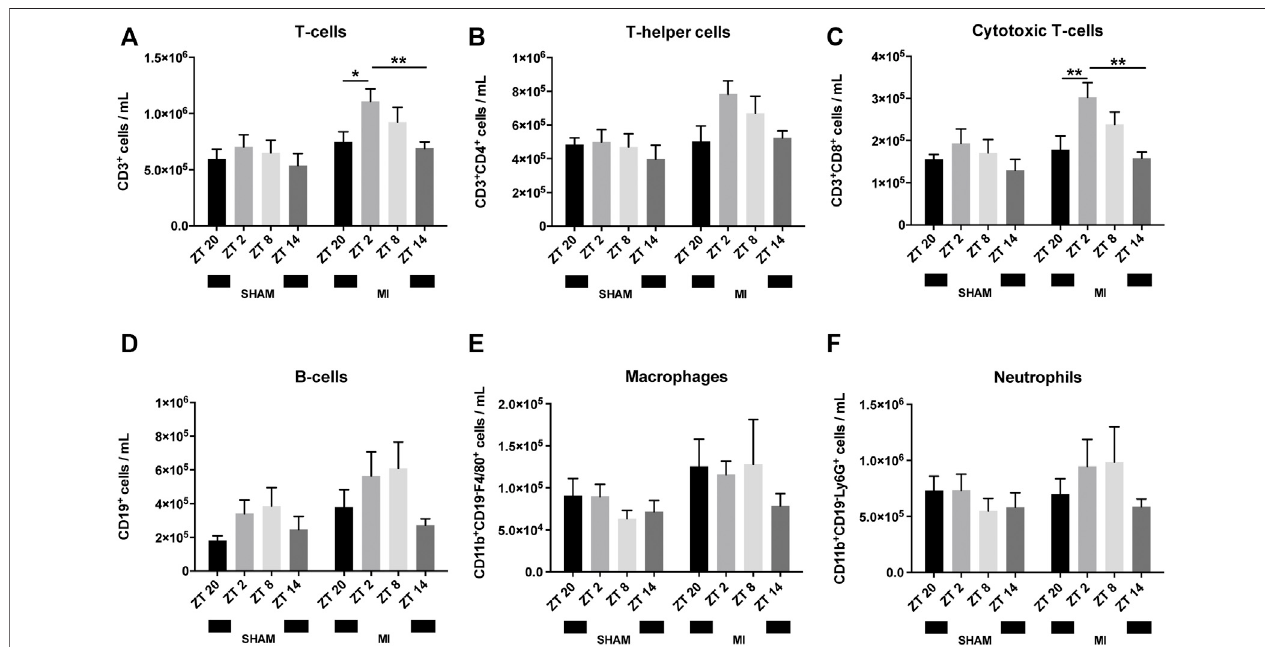
FIGURE2| Leukocytenumbersinbloodaftersurgery.NumberofcirculatingT-cells (A) ,T H -cells (B) ,T C -cells (C) ,B-cells (D) ,macrophages (E) andneutrophils (F) ( n = 5 – 6 per group for all analysis) ( *p < 0.05, **p < 0.01 by one-way ANOVA with LSD test).